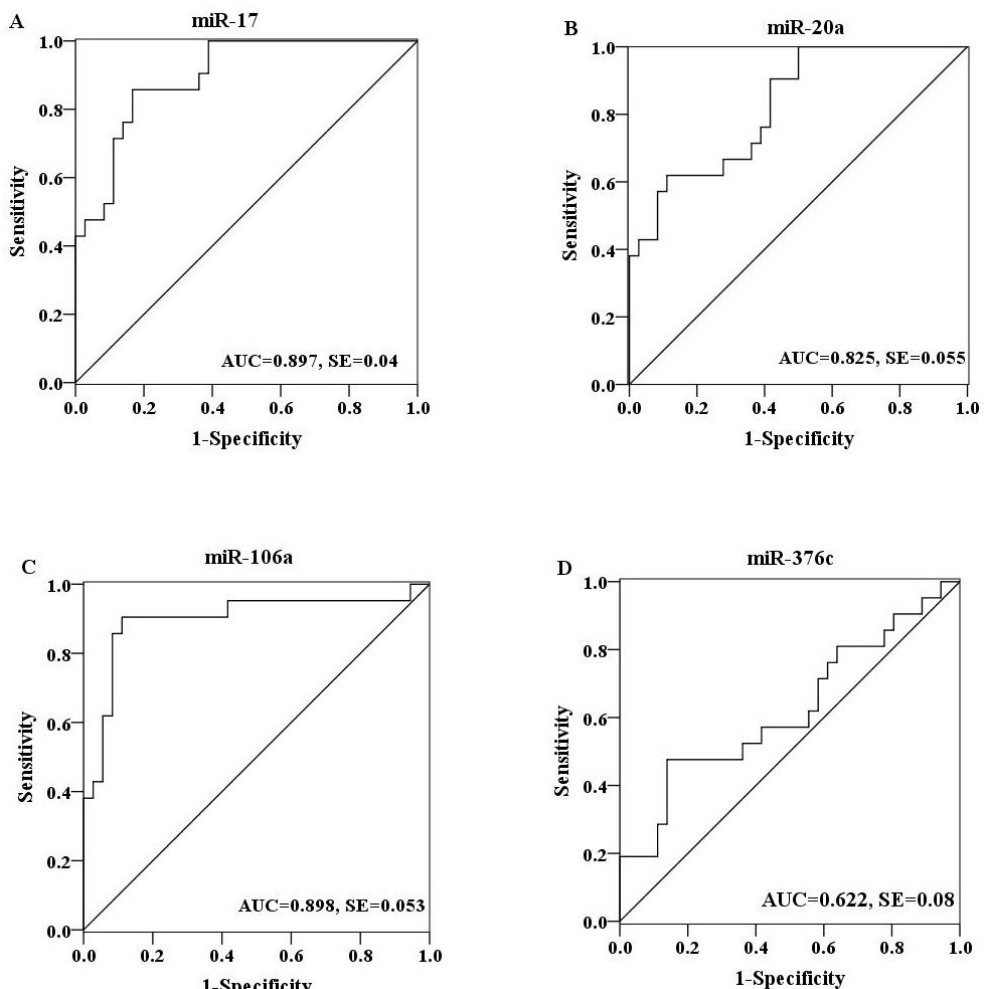
Figure 3. ROC curves were constructed to evaluate the diagnostic potential of serum miRNAs for H7N9 virus infection. MiR-17 ( A ), miR-20a ( B ) and miR-106a ( C ) showed a moderate discriminating efficiency with an AUC value more than 0.8, while miR-376c ( D ) exhibited a poor diagnostic ability with an AUC value of